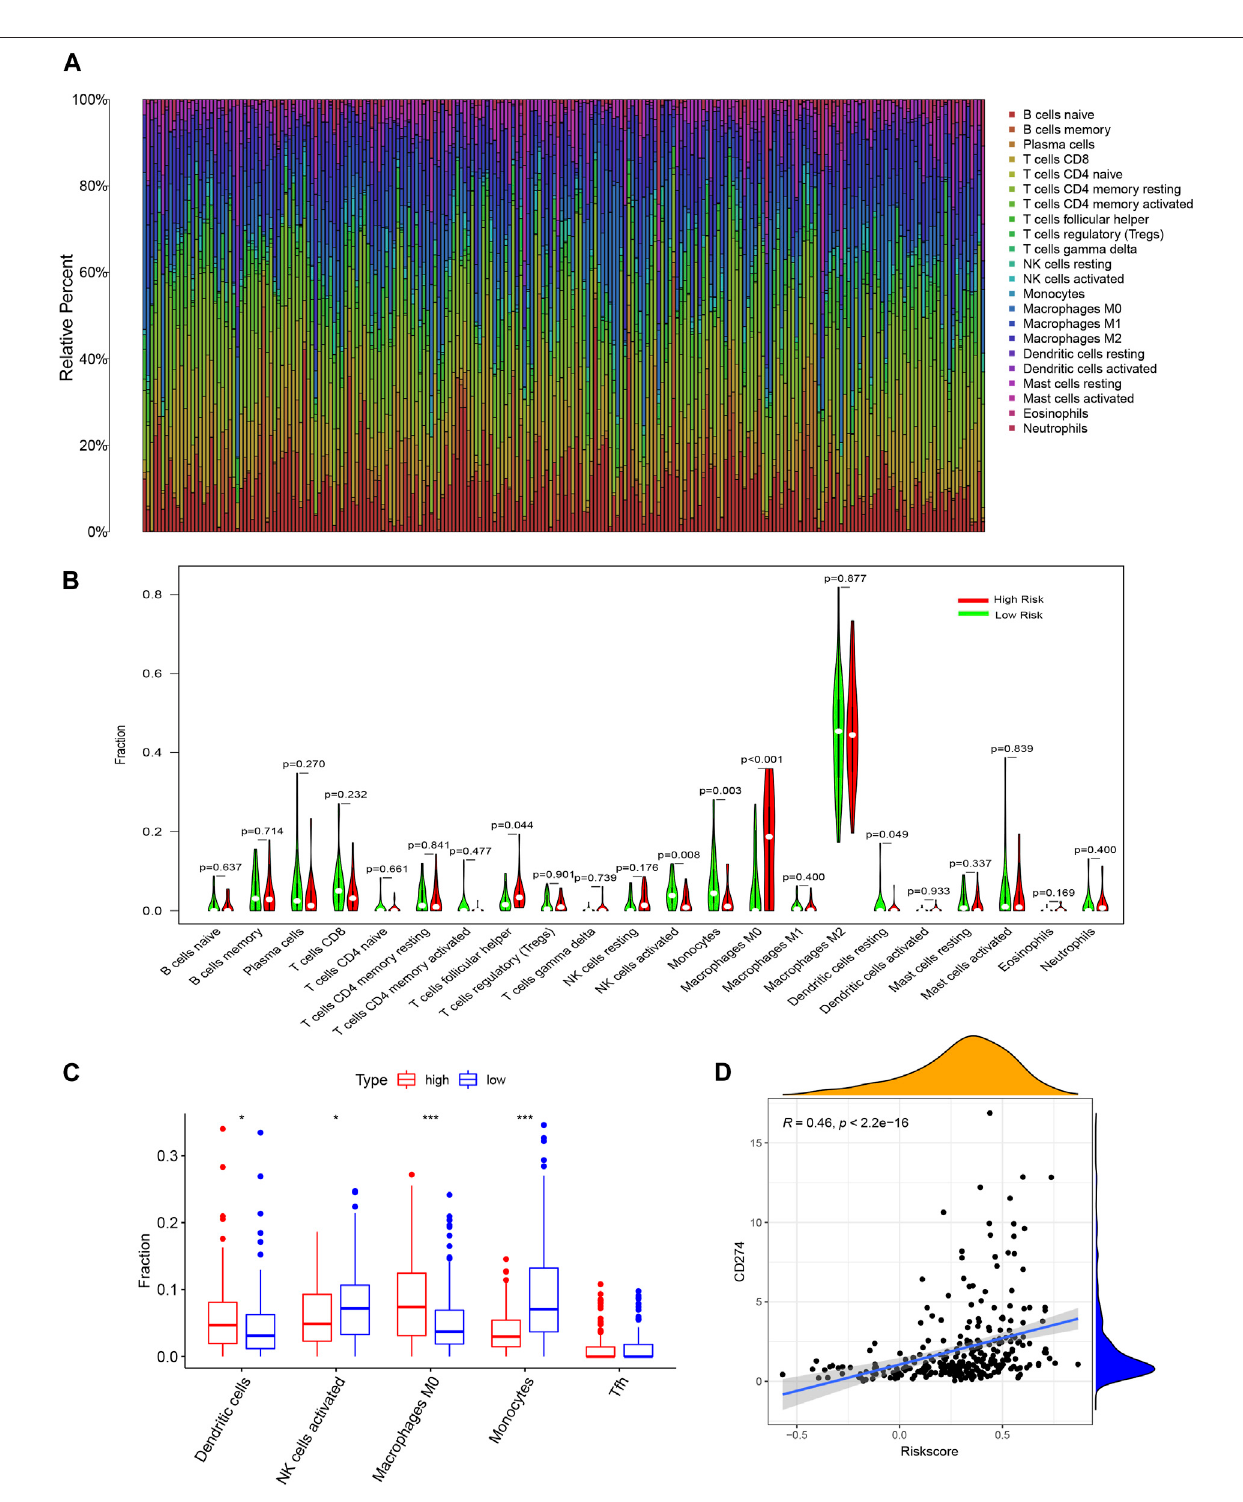
FIGURE7 | Analysisof risk-signaturein immune-related activities ofglioma. (A) Barplot showing the proportion of21 kinds oftumor-in fi ltratingimmunecells (TICs) in CGGA GBM samples (calculating through CIBERSORT). (B) Violin plot showed the ratio differentiation of 21 kinds of immune cells between CGGA glioma samples with low or high risk score. (C) Fraction of immune cells examined through xCell methods. (D) Correlation between level of CD274 (PD-L1) and riskscore.